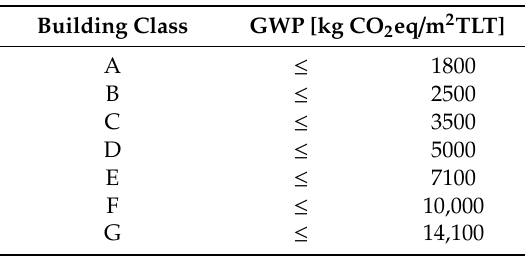
Table 9. Building rating